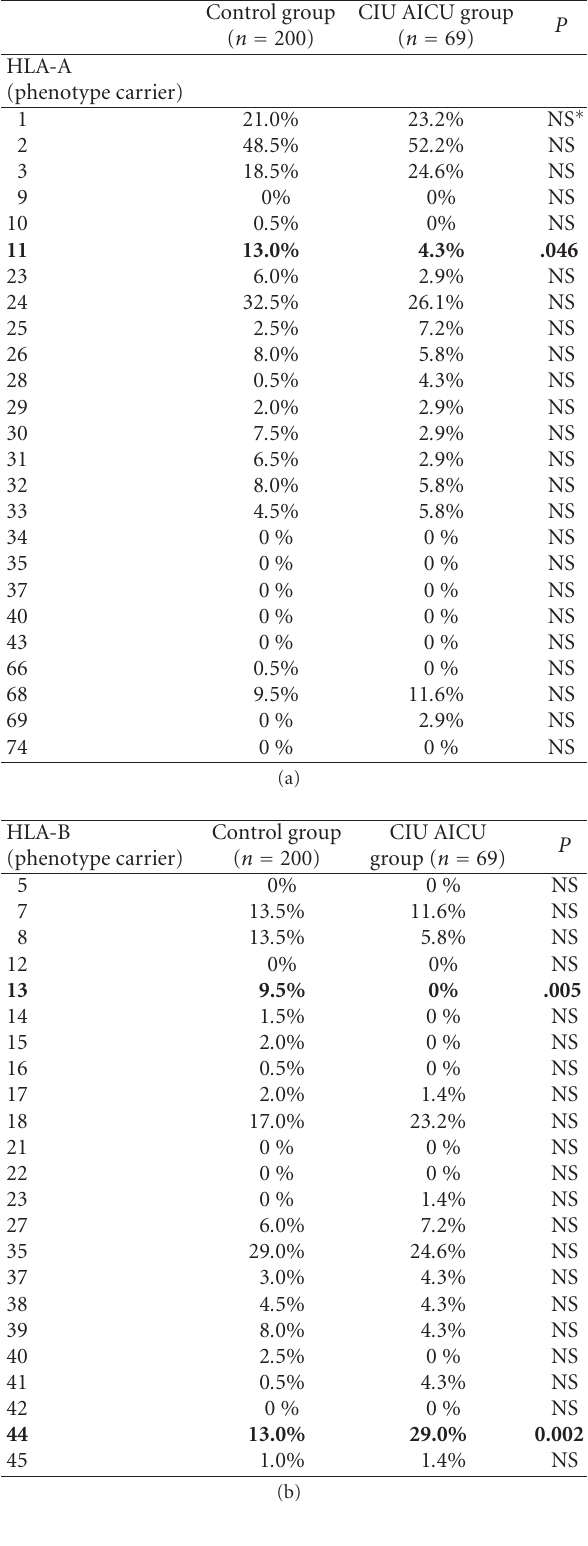
Table 1: (a)–(d): HLA class-I (A, B, and Cw) phenotypes and HLA- DRB1 (cid:0) genotypes in patients a ff ected by AICU and in the control